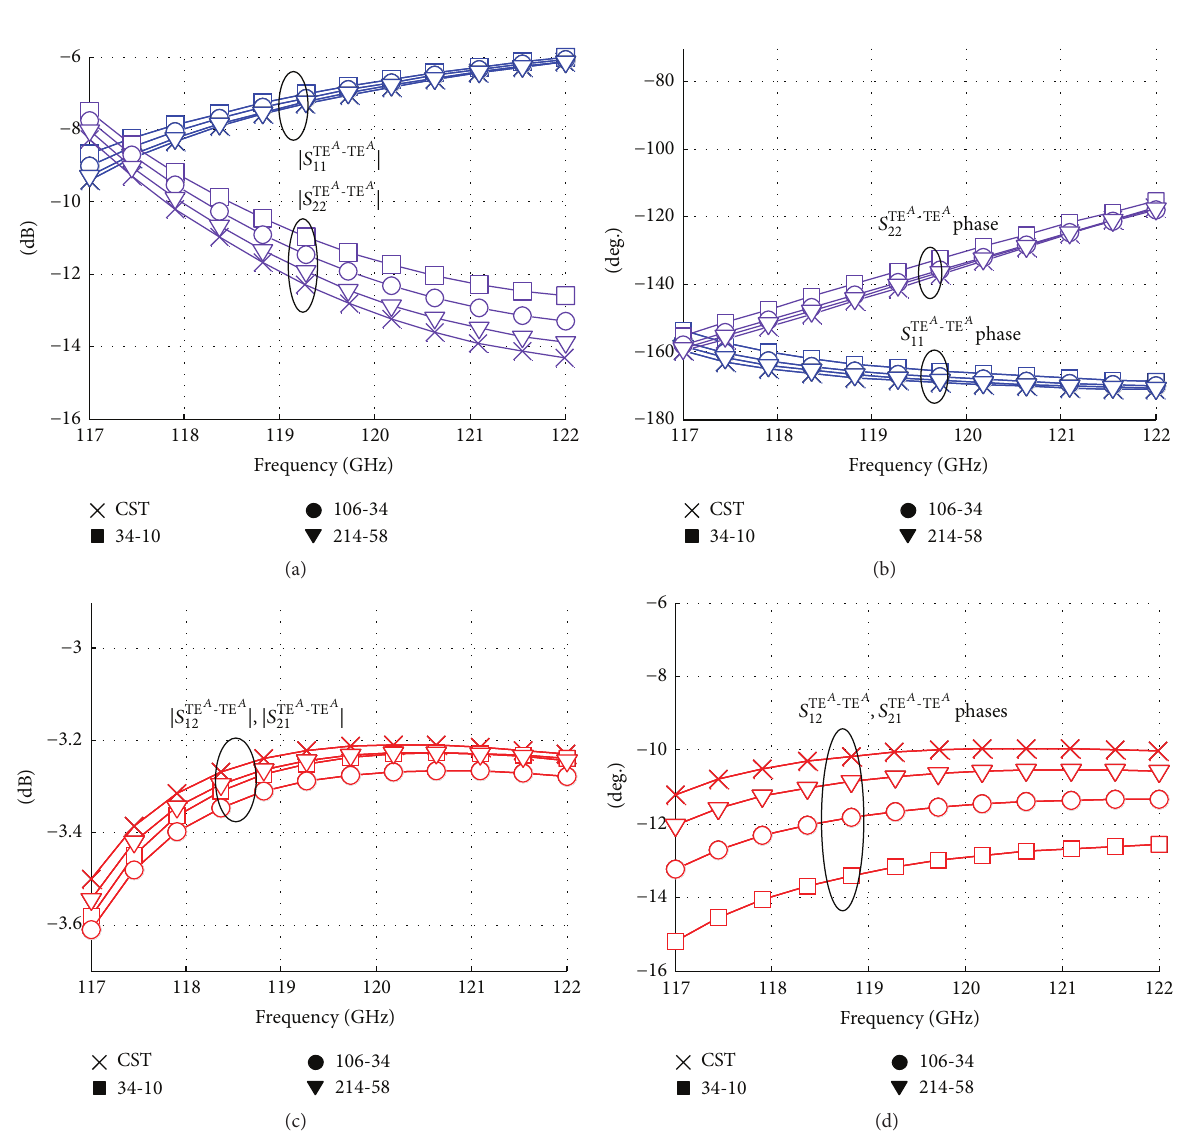
Figure 9: Case study b: mode TE 𝐴 10 in waveguide 1 to mode TE 𝐴 10 in waveguide 2 : (a) reflection magnitude, (b) reflection phase, (c) transmission magnitude, and (d) transmission